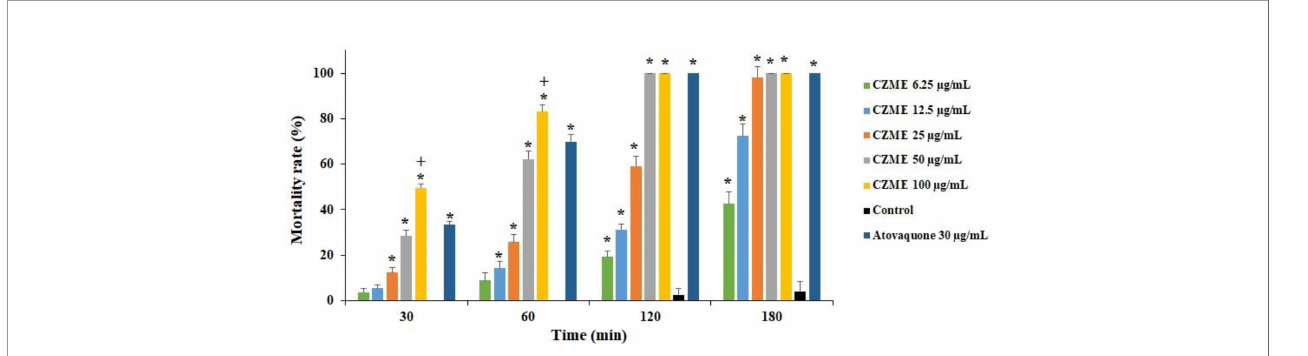
FIGURE 1 | In vitro effects of C. zeylanicum methanolic extract (CZME) against T. gondii tachyzoites after different incubation times. Results are displayed as the mean ± SD (n = 3). *P < 0.001 represents a signi fi cant difference in comparison with the control group; +p < 0.001 represents a signi fi cant difference in comparison with the